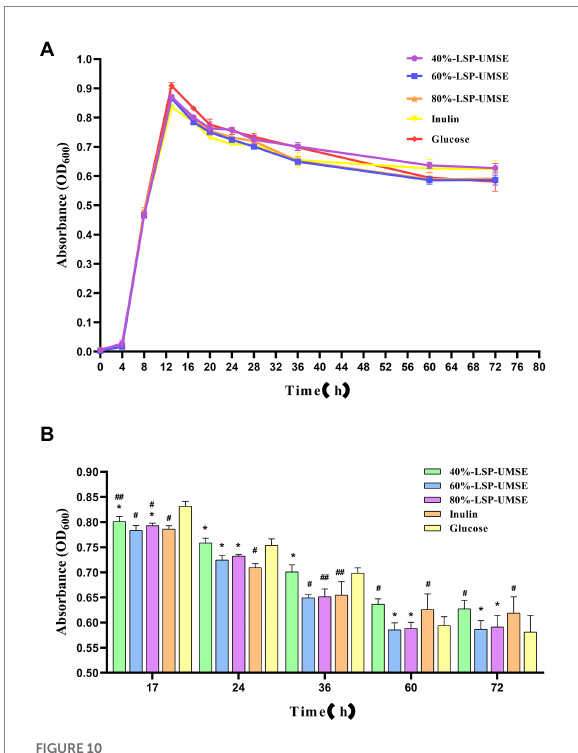
FIGURE 10 (A) Growth promotion curve of 0.5% complex polysaccharide (monosaccharide: polysaccharides = 9:1) MRS; (B) OD 600 of 0.5% complex polysaccharide (monosaccharide: polysaccharide = 9:1) MRS culture. (Note: inulin was used as control, * was significantly p < 0.05; when glucose was used as control, # was significantly p < 0.05.)